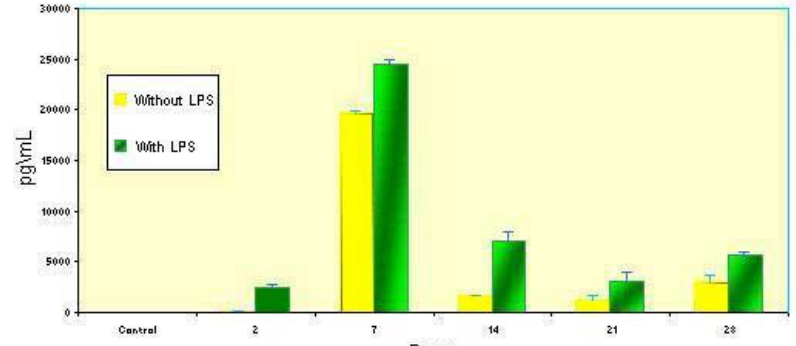
Figure 1. Evaluation of production of antibodies anti- Leptospira interrogans Canicola. Values were expressed as logarithm, according to the Kruskal-Wallis non-parametric test for independent variables ( α =05).